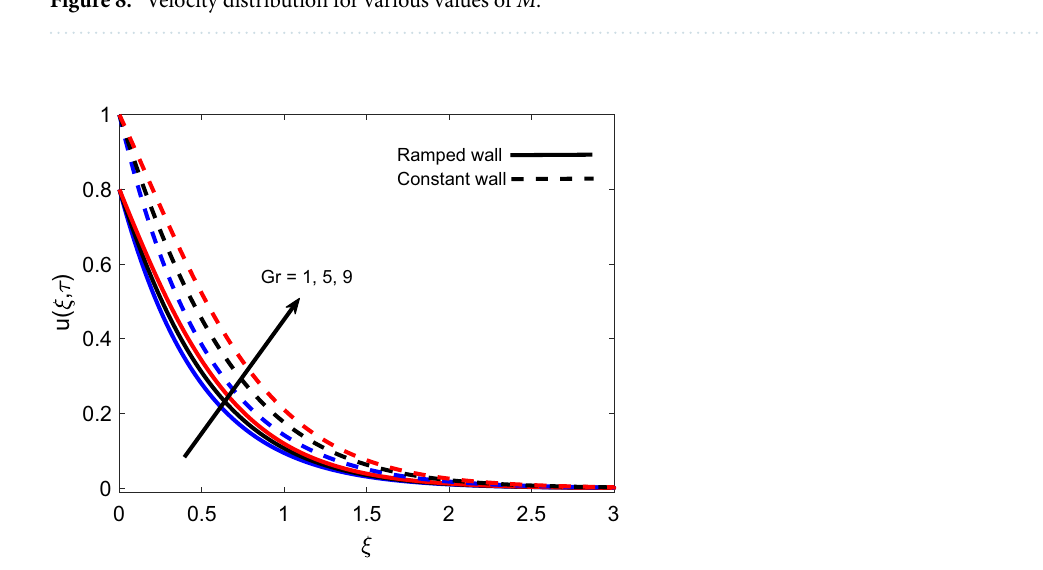
Figure 8. Velocity distribution for various values of M .